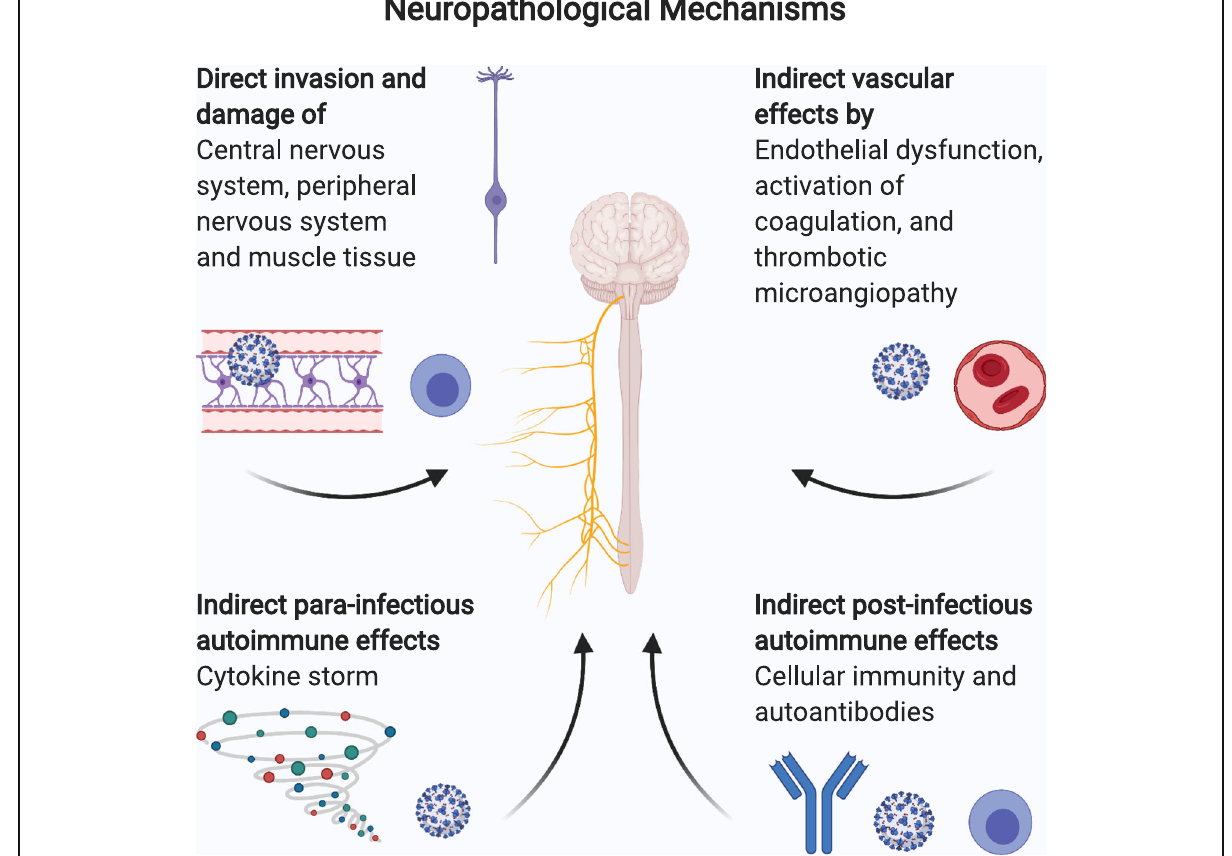
Fig. 2 Neuropathological mechanisms (Created with